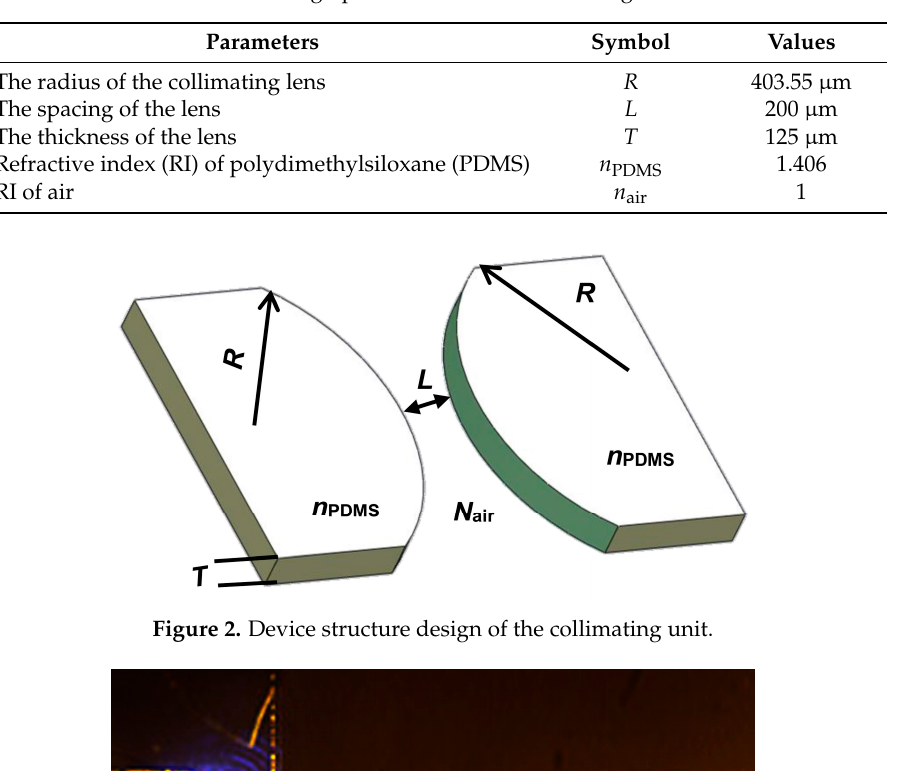
Figure 4. Device structure design of the focusing unit.